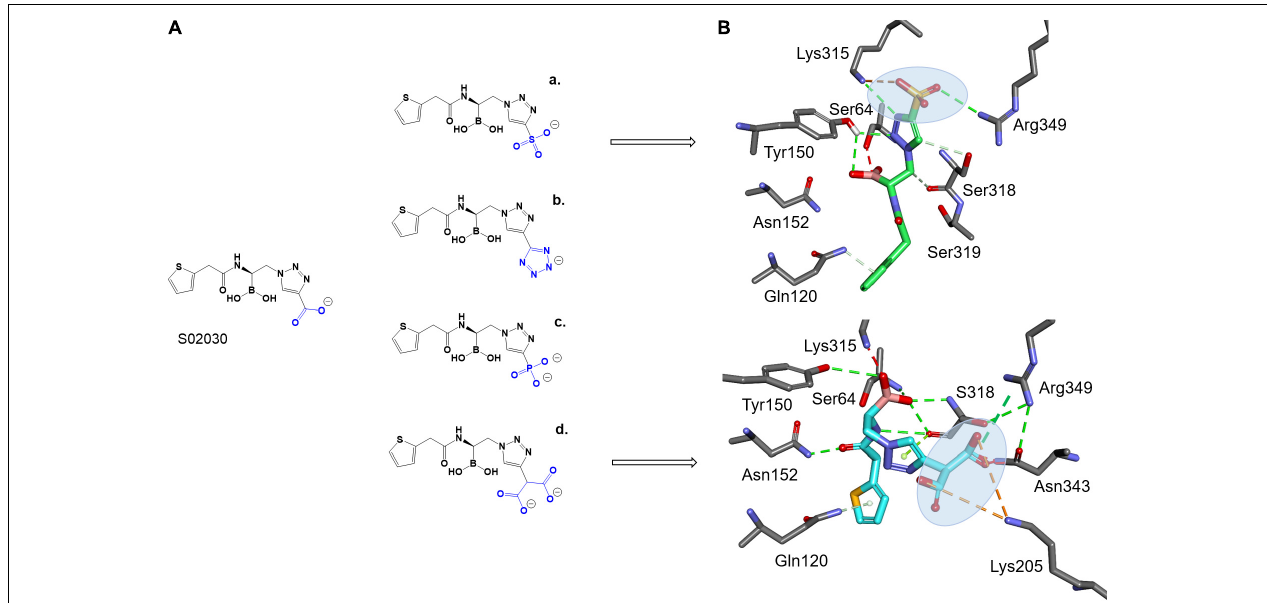
FIGURE 4 | Proposed derivatives of S02030 that mimic ATM (A) docked as acyl enzyme complexes into the active site of MOX-1 (B) . The new added moieties are targeting the active site residues Lys315, Asn343, and new interactions with Arg349 and Lys205 for better